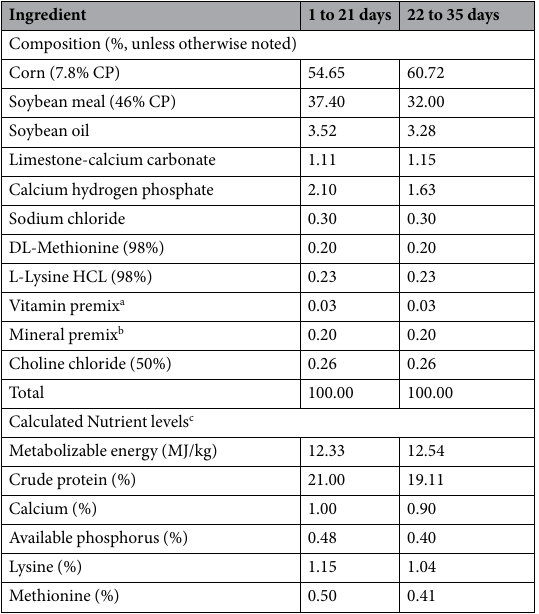
Table 4. Composition and nutrient levels of the basal diet. a Vitamin premix provided per kg of complete diet: vitamin A (retinylacetate), 9500 IU; vitamin D 3 (cholecalciferol), 2500 IU; vitamin E (DL-a-tocopherol acetate), 30 IU; vitamin K 3 (menadione sodium bisulfate), 2.65 mg; vitamin B 12 (cyanocobalamin), 0.025 mg; biotin, 0.30 mg; folic acid, 1.25 mg; nicotinic acid, 50 mg; d-pantothenic acid, 12 mg; pyridoxine hydrochloride, 6.0 mg; riboflavin, 6.5 mg; thiamine mononitrate, 3.0 mg. b Mineral premix provided per kg of complete diet: iron,